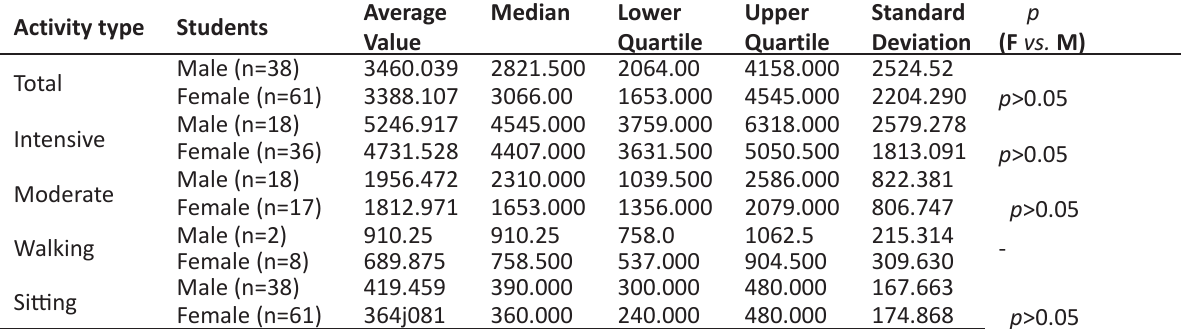
Table 3. Correlation PAR-Q test result vs. activity level